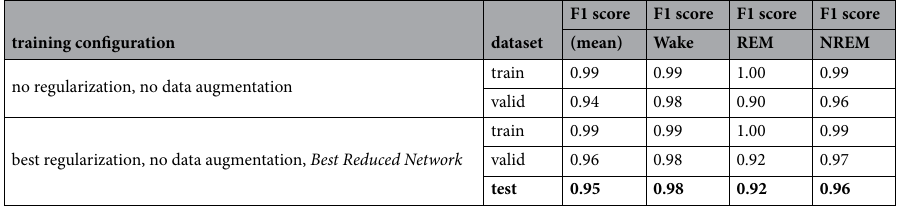
Table 4. F1 scores for the training, validation, and test set for predicting the three main stages Wake, REM, and NREM sleep at various configurations of the hyperparameters. The network was trained on the rebalanced training set #2 (see Table 2). Only the best configuration (best reduced network) was evaluated on the test set.